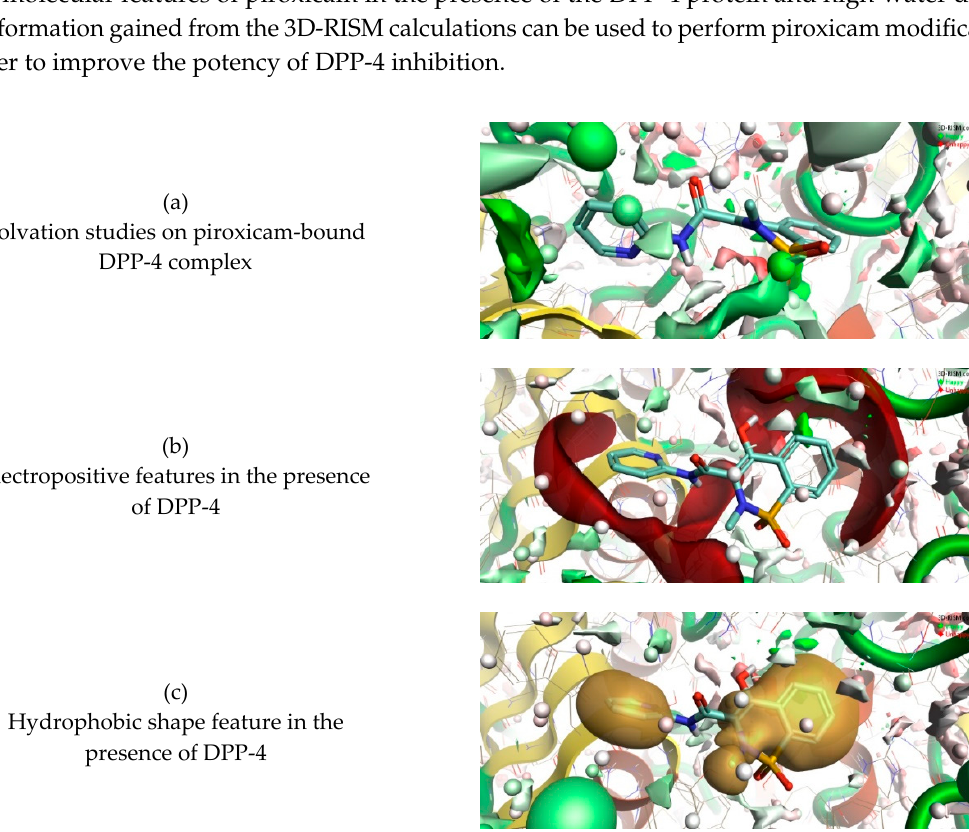
Figure 4. Prediction of piroxicam molecular features: positive electrostatics, negative electrostatics, and hydrophobic shape calculated using XED force field, provided by the Activity Atlas model in comparison with DPP-4 inhibitors in clinical use.